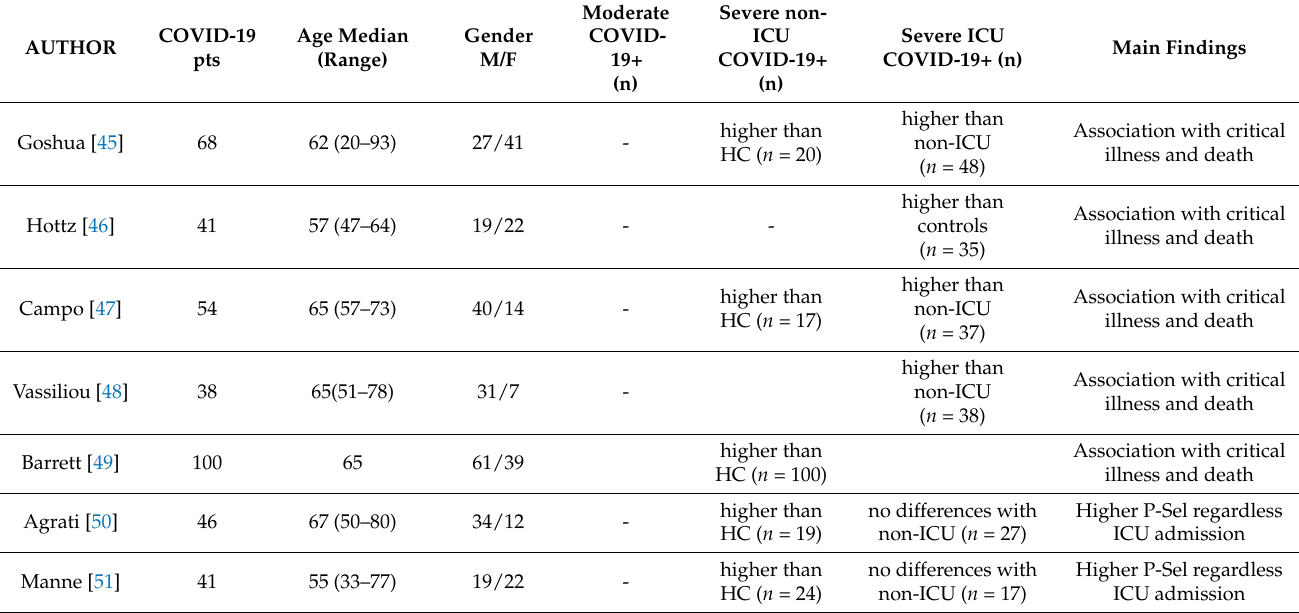
Table 1. Studies on P-selectin in COVID-19 patients.